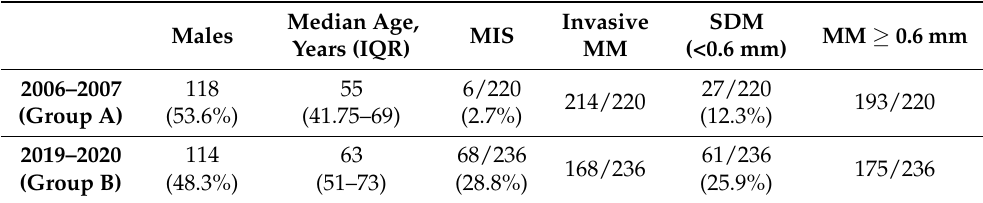
Table 2. Characteristics of cutaneous melanomas excised in the period 2006–2007 and 2019–2020 at the Dermatology Unit of Fondazione IRCCS Ca’ Granda Ospedale Maggiore Policlinico, Milan,